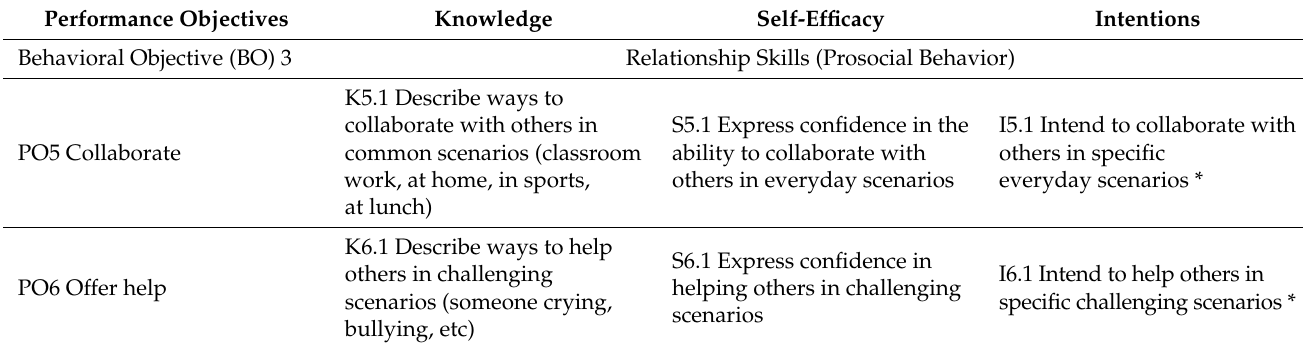
Table 3. Matrix of Change Objectives: Relationship